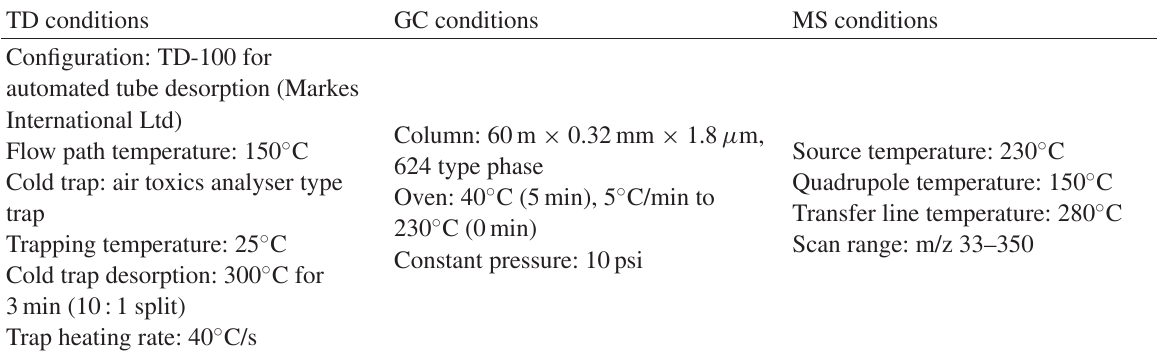
TABLE 8: Sampling and analytical